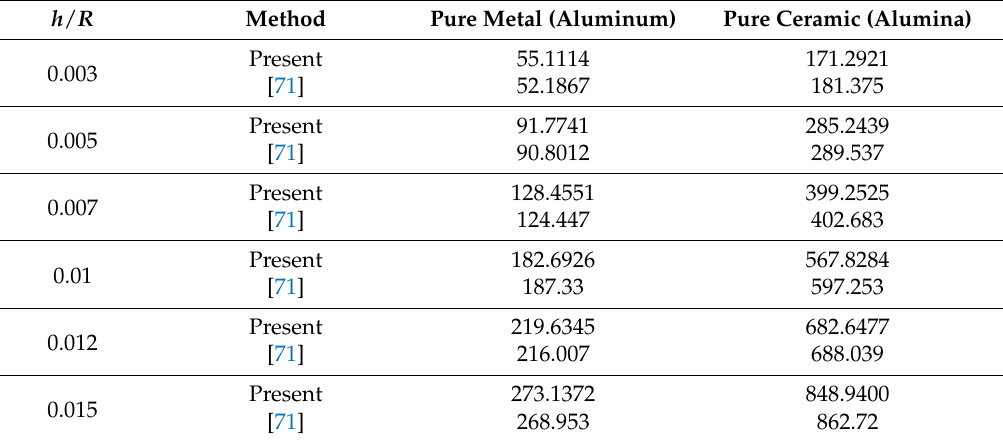
Table 1. Thermal buckling ∆ T cr as predicted by the present work and [71] for a uniform temperature rise and L / R = 1.